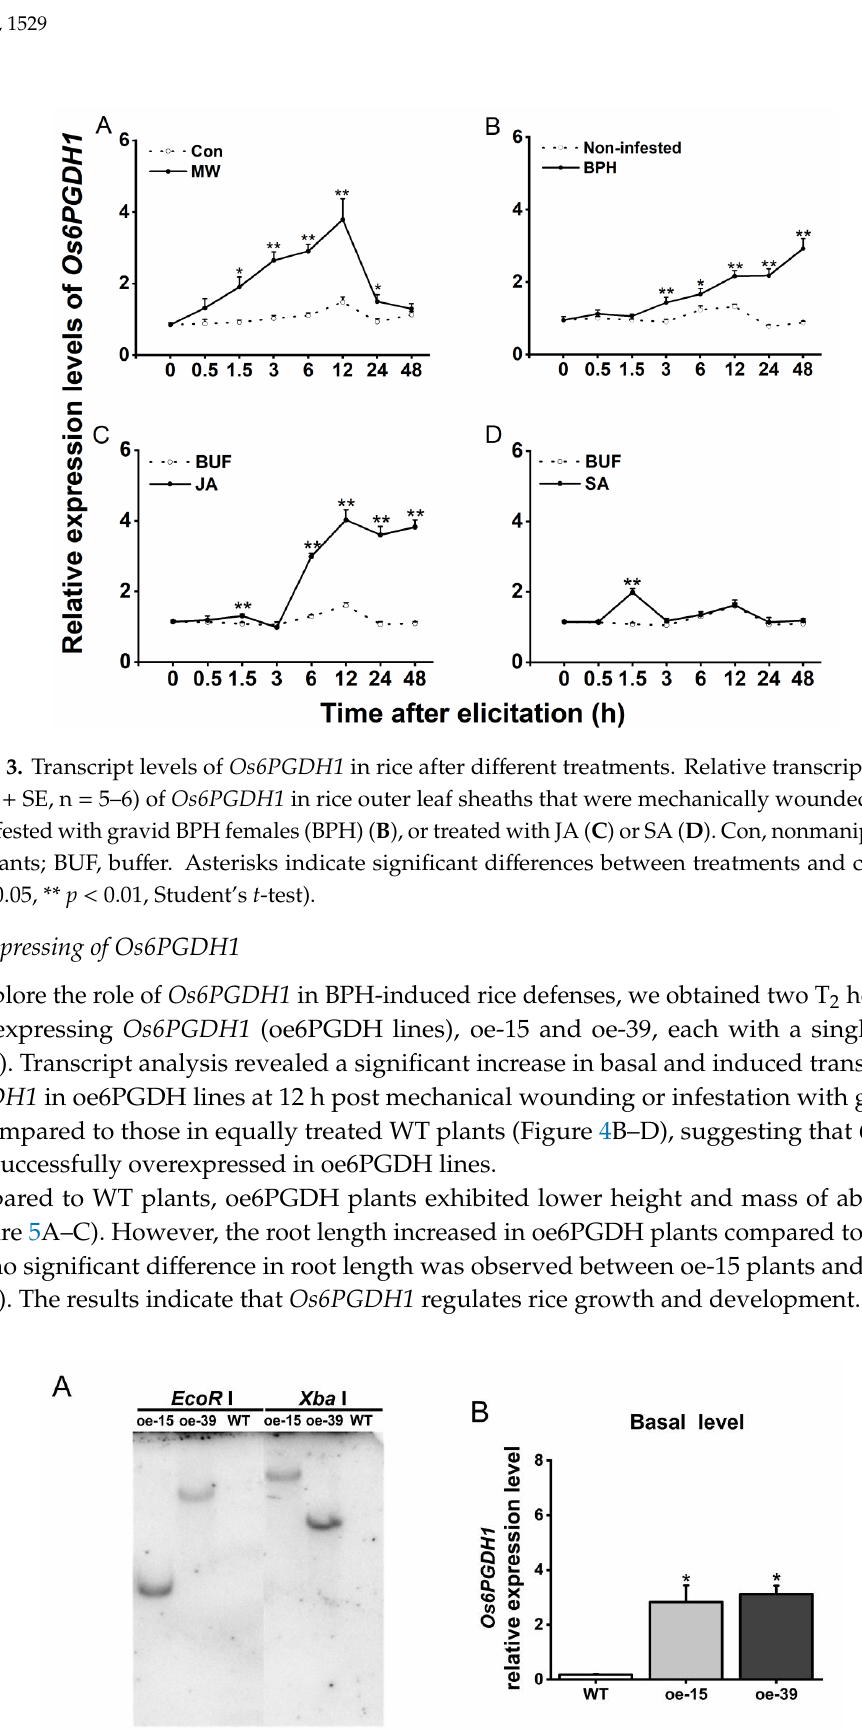
Figure 4. Molecular confirmation of transgenic lines overexpressing Os6PGDH1 . ( A ) Southern blot of Os6PGDH1 -overexpressing lines and WT plants. Genomic DNA from oe-15, oe-39, and WT plants was digested with EcoR I and Xba I, respectively. Digested genomic DNA was hybridized to a specific GUS probe. ( B ) Basal expression levels (means + SE, n = 5) of Os6PGDH1 in oe6PGDH lines and WT plants; ( C , D ) relative transcript levels (means + SE, n = 5) of Os6PGDH1 in oe6PGDH lines and WT plants that were mechanically wounded or infested by gravid BPH females for 12 h (these experiments were performed separately). Asterisks indicate significant differences in oe6PGDH lines compared with WT plants (one-way ANOVA followed by Duncan’s multiple range test, p < 0.05). Compared to WT plants, oe6PGDH plants exhibited lower height and mass of aboveground parts (Figure 5A–C). However, the root length increased in oe6PGDH plants compared to WT plants, although no significant difference in root length was observed between oe-15 plants and WT plants (Figure 5D). The results indicate that Os6PGDH1 regulates rice growth and development.